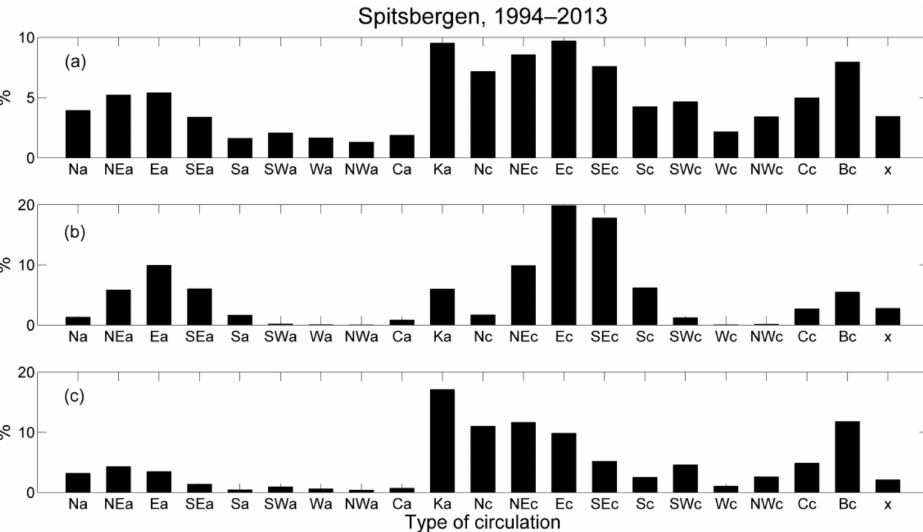
Figure 2. Distribution of types of synoptic situations (circulation types): ( a ) during the entire studied period in Svalbard, 1994–2013; ( b ) when the mesoscale land-sea breeze type circulation was recorded in Hornsund and Ny-Ålesund at the same time; ( c ) when the mesoscale land-sea breeze type circulation was not visible. 100% is all measurements when this factor is observed. 100% is all measurements when this factor is